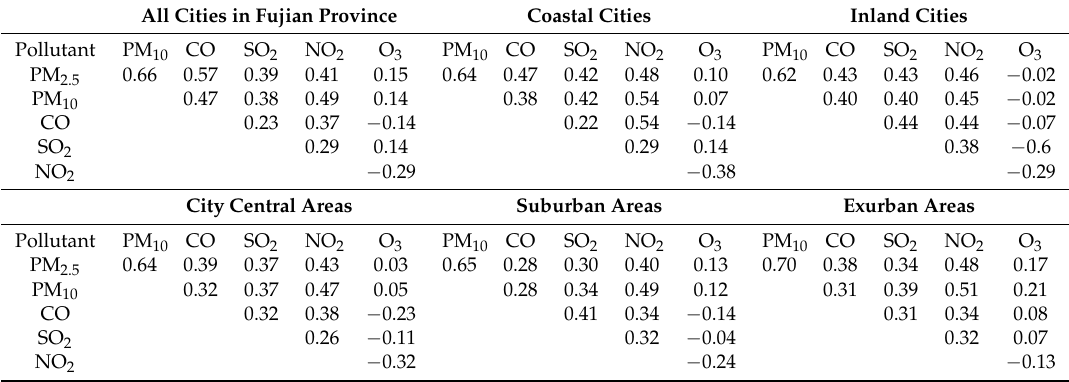
Table 5. Correlations of pollutants in five regions based on the hourly data of the study period during 1 January 2015 to 31 December 2016. All Cities in Fujian Province Coastal Cities Inland Cities